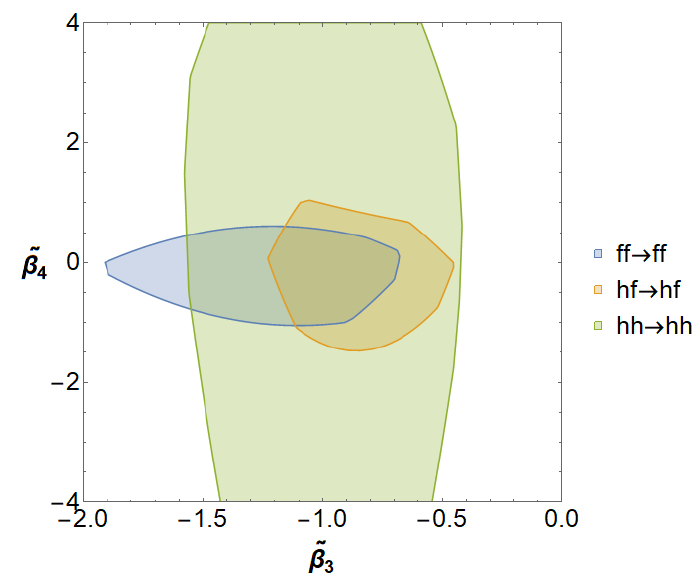
Figure 11 . The allowed regions in the ( ~ (cid:12) 3 ; ~ (cid:12) 4 ) plane in the case of ~ (cid:11) 3 = 1 ; ~ (cid:11) 4 = 0 for the mass ratios ~ x = 2 : 2 ; (cid:13) = 1 (corresponding to a mixing angle (cid:18) = 0 : 1). For the (generic) allowed values of (~ (cid:11) 3 ; ~ (cid:11) 4 ) the constraints on ( ~ (cid:12) 3 ; ~ (cid:12) 4 ) come mainly from the ff ! ff and hf ! hf